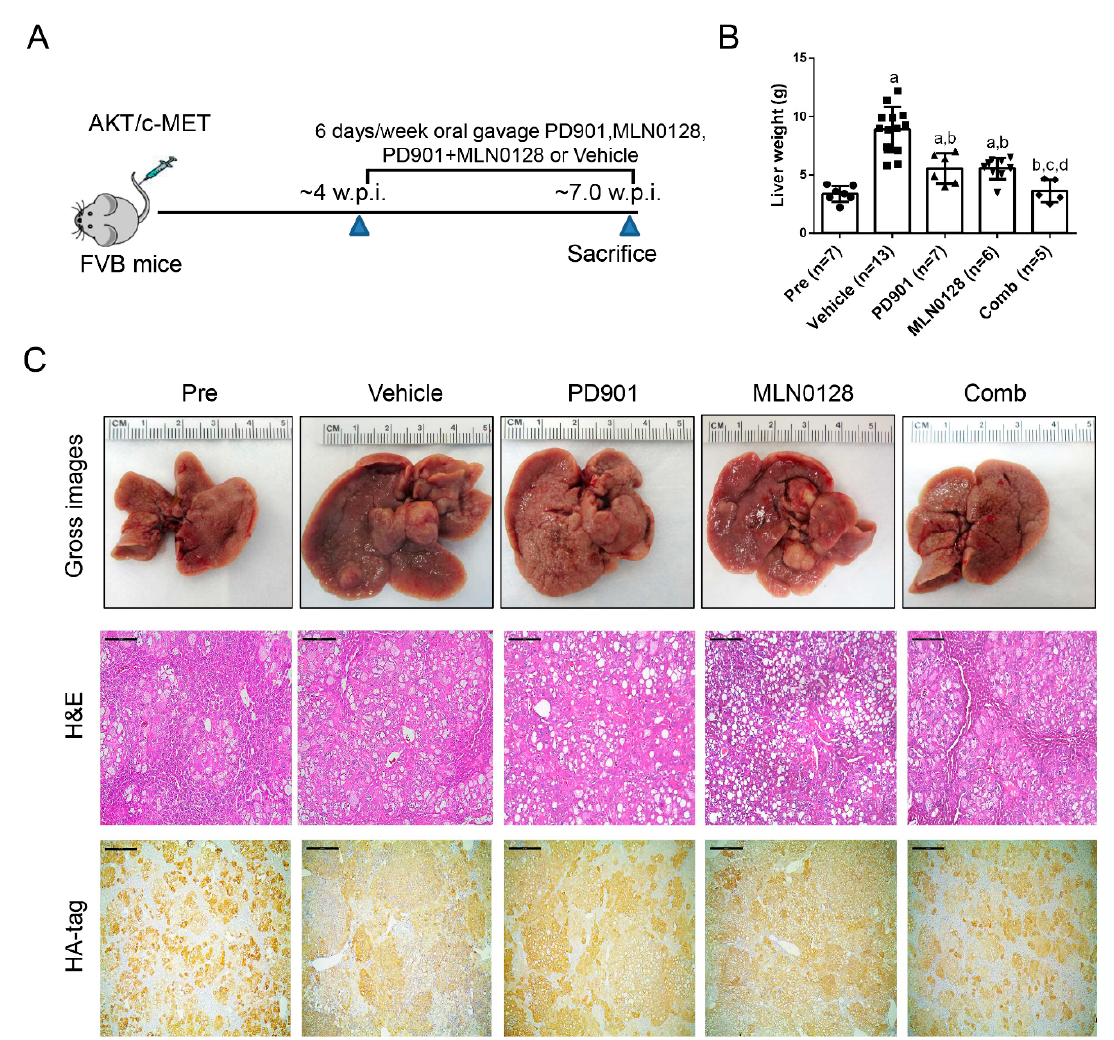
Figure 7. Effects of PD901/MLN0128 combination on hepatocarcinogenesis in AKT/c-MET mice. ( A ) Study design. ( B ) Liver weight of pre-treatment, vehicle-, MLN0128-, PD901-, and PD901/MLN0128- treated AKT/c-MET mice. ( C ) Gross images and H&E and HA-tag staining of livers from pre- treatment, vehicle-, PD901-, MLN0128-, PD901-, PD901/MLN0128-treated AKT/c-MET mice.